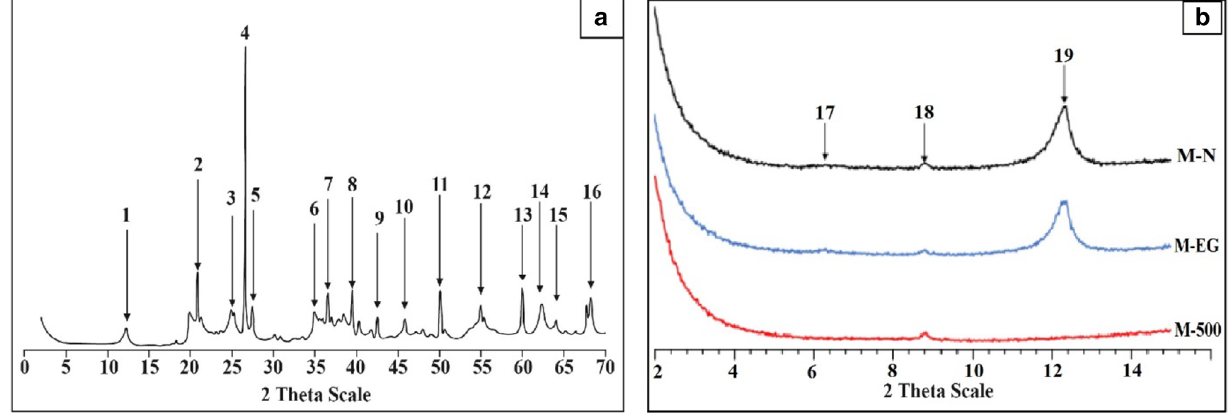
Fig. 3 XRD diffractograms of the alluvial clay on total powder ( a ) and on clay fraction ( b ); 1. 7.27 Kao, 2. 4.26 Gt, 3. 3.53